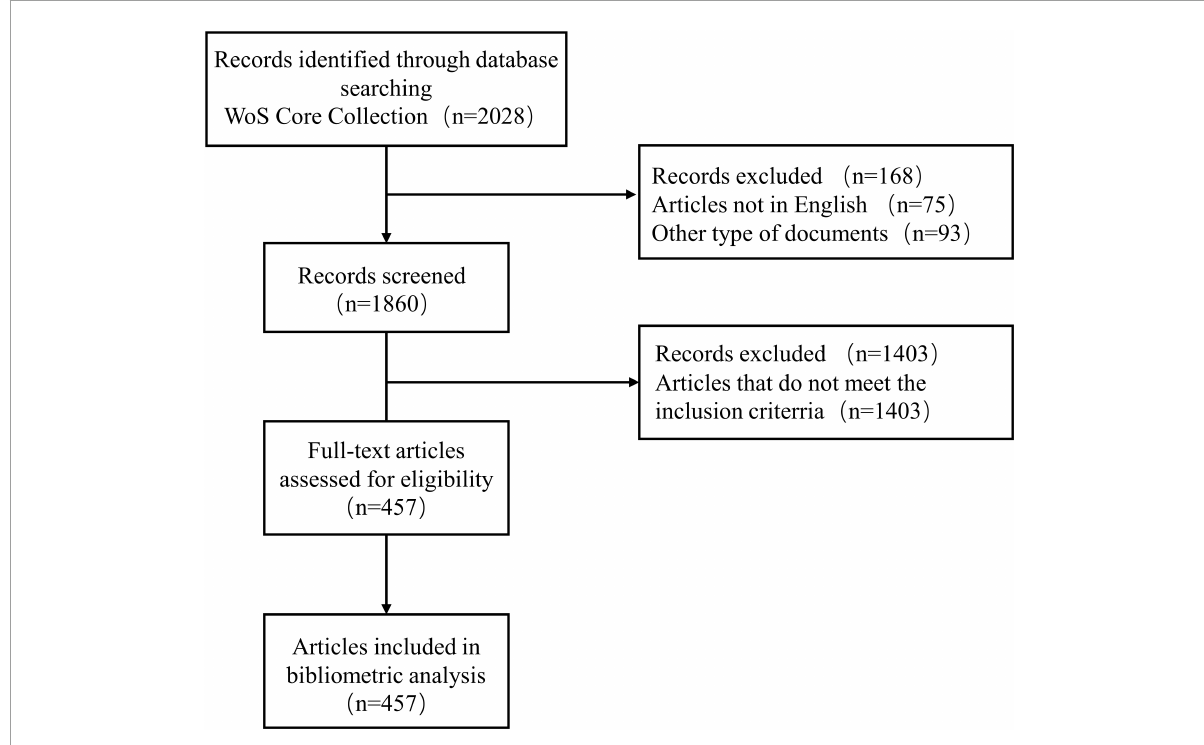
FIGURE1 Flowchart of literature identification and